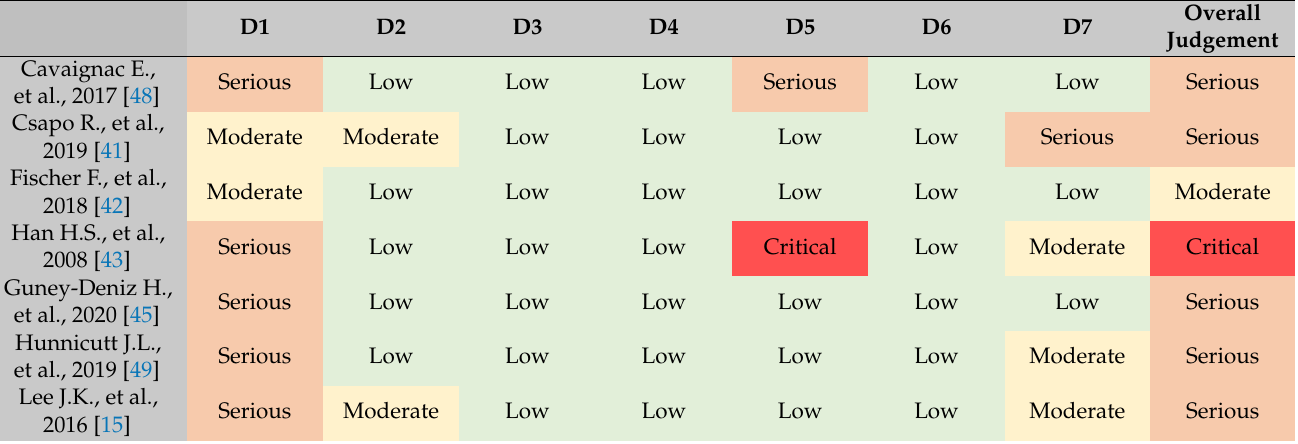
Figure 2. Cochrane collaboration risk of bias summary [14,44,47]. Table 2. Robins-I scale for the risk of bias assessment of non-randomized studies.